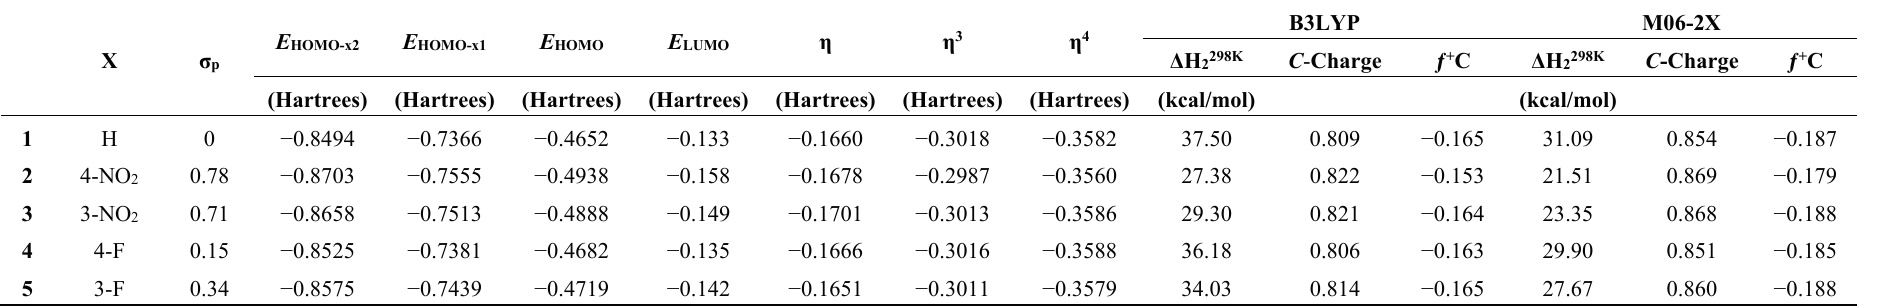
Table 2. Calculated properties for the protonated 4- or 3-X-cinnamic acids: Hammett substituent constants ( σ p ), molecular orbital energies (in hartrees), hardness parameters ( η , η 3 and η 4 , in hartrees), standard enthalpy variation (second step, in kcal/mol), atomic charges and ƒ + C Fukui function. B3LYP and M06-2X results are both given for